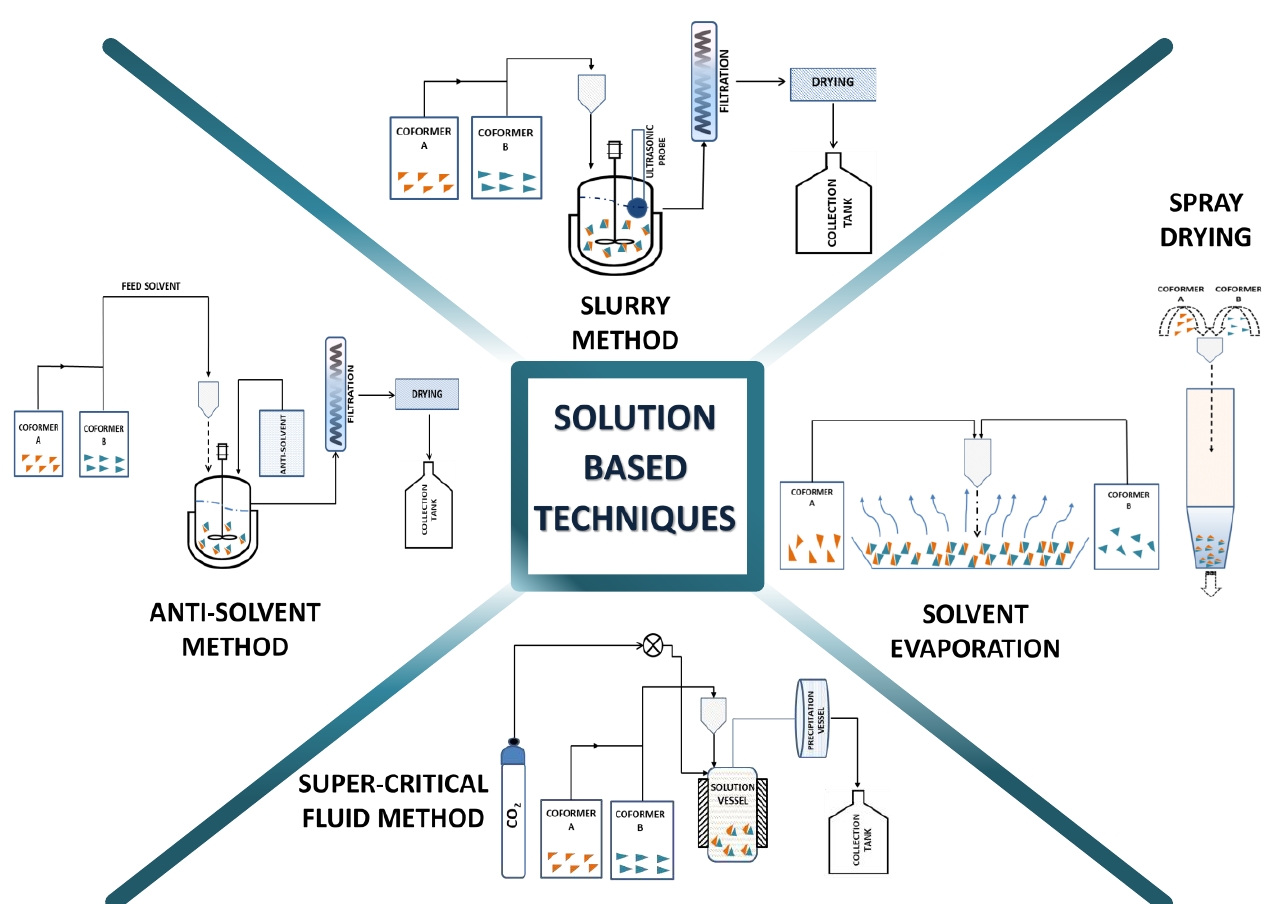
Figure 1. Schematic representation of the commonly used solution based cocrystallization techniques.